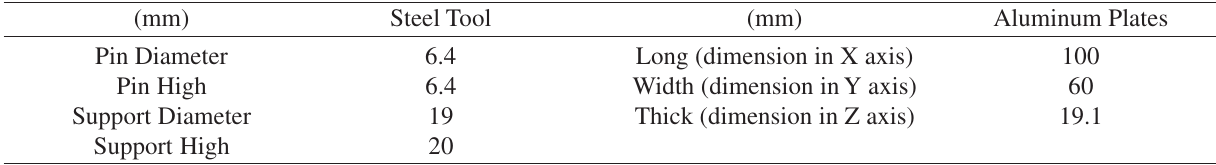
Table 2. Dimensions of the tool and the aluminum plate.